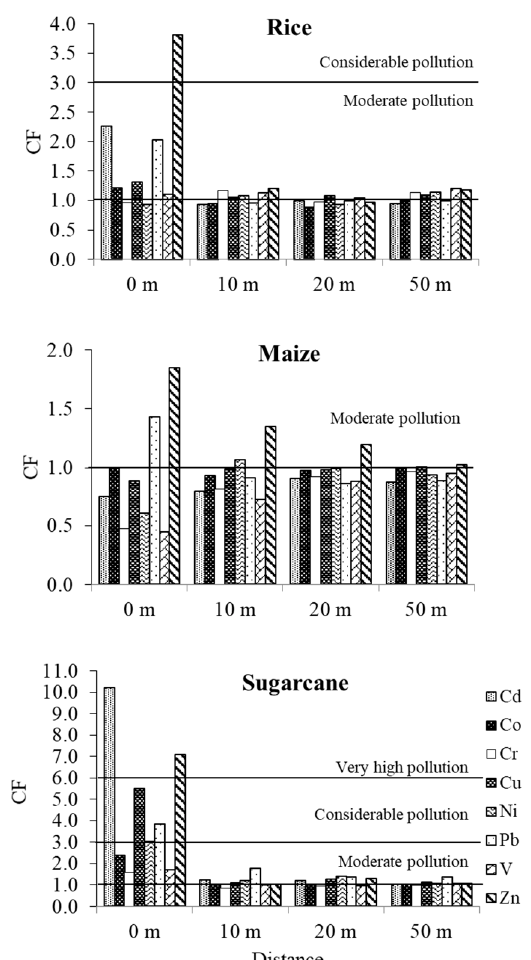
Figure 6. The contamination factor (CF) for Cd, Co, Cr, Cu, Ni, Pb, V and Zn in roadside agricultural soils under rice, maize and sugarcane cultivation.